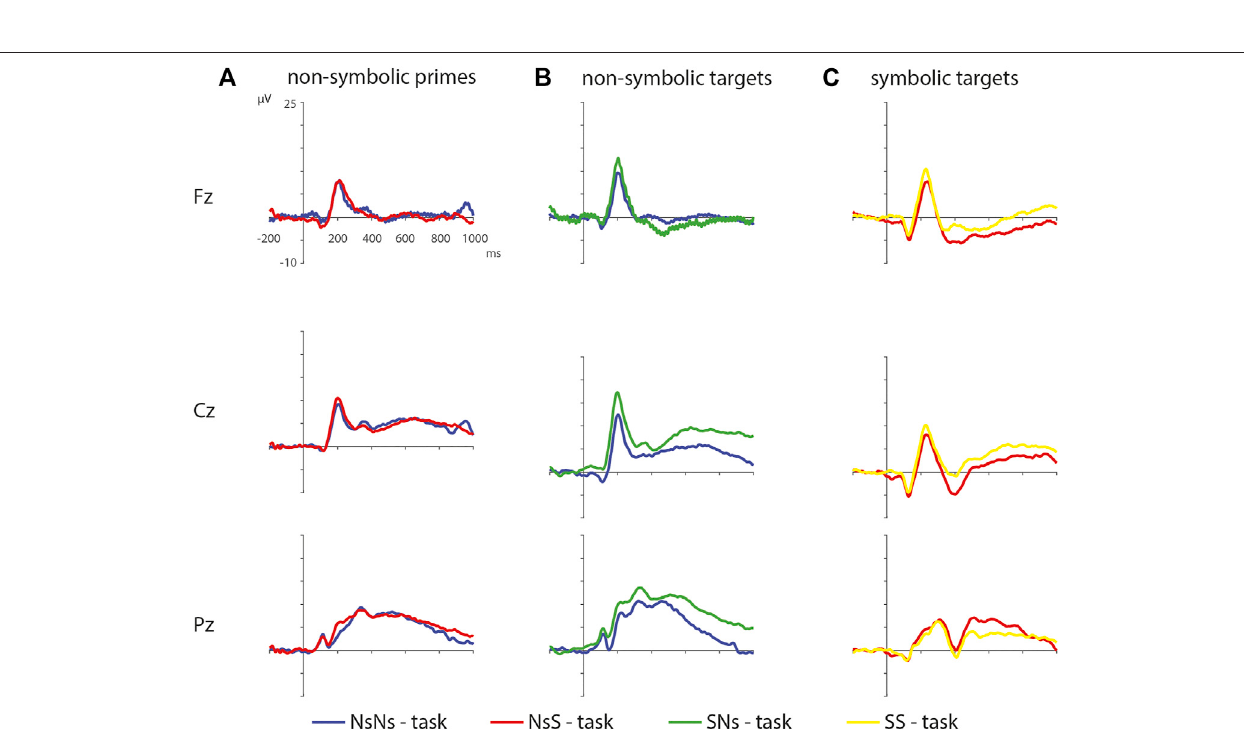
Frontiers in Education |